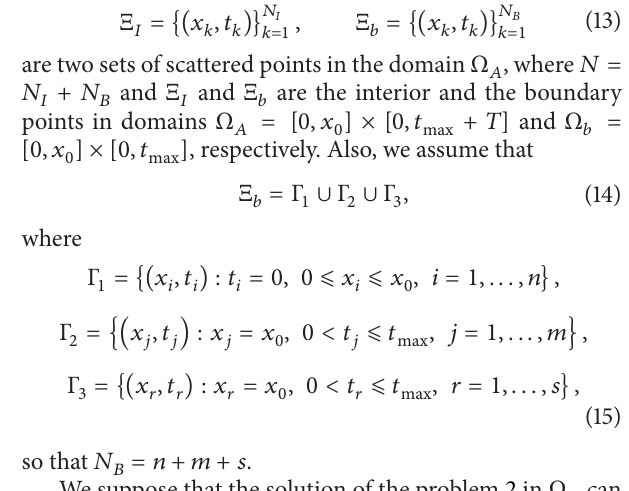
Table 1: Some well-known radial basis functions. Infinitely smooth RBFs 𝜓(𝑟) Gaussian (GA) 𝑒 (−𝑐𝑟 Multiquadrics (MQ) √𝑟 2 + 𝑐 2 Inverse multiquadrics (IMQ) (√𝑟 2 + 𝑐 2 ) Inverse quadric (IQ) (𝑟 2 + 𝑐 2 ) −1